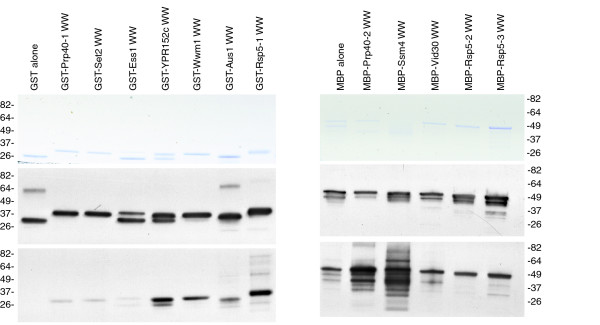
Purification of WW domain fusion proteins. Coomassie-stained SDS-PAGE gel of WW domain fusion proteins following protein purification (top panels), western blot detection of fusion protein expression with anti-GST antibody (left middle panel) or anti-myc antibody (right middle panel), and biotinylation of fusion proteins observed by binding of HRP-conjugated streptavidin (bottom panels) are shown.